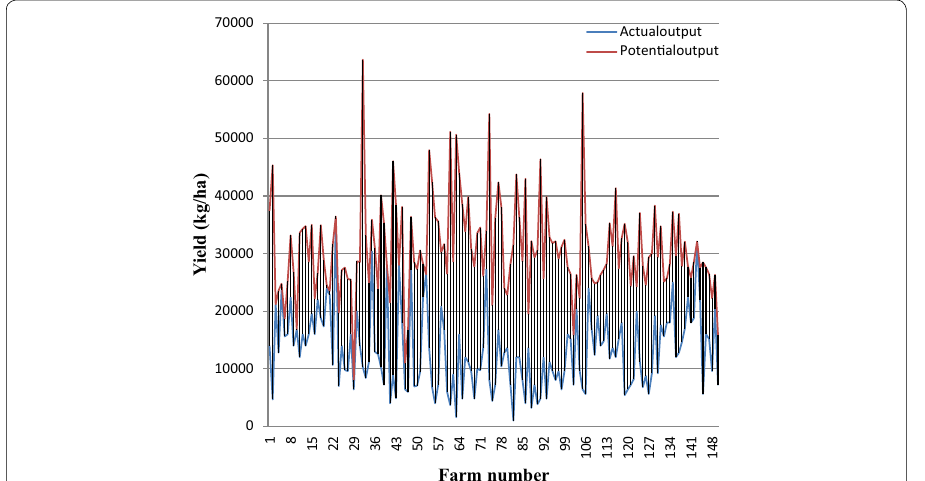
Fig. 3 Comparison of the actual and the potential level of yield (Source: Computed from Field Survey Data,